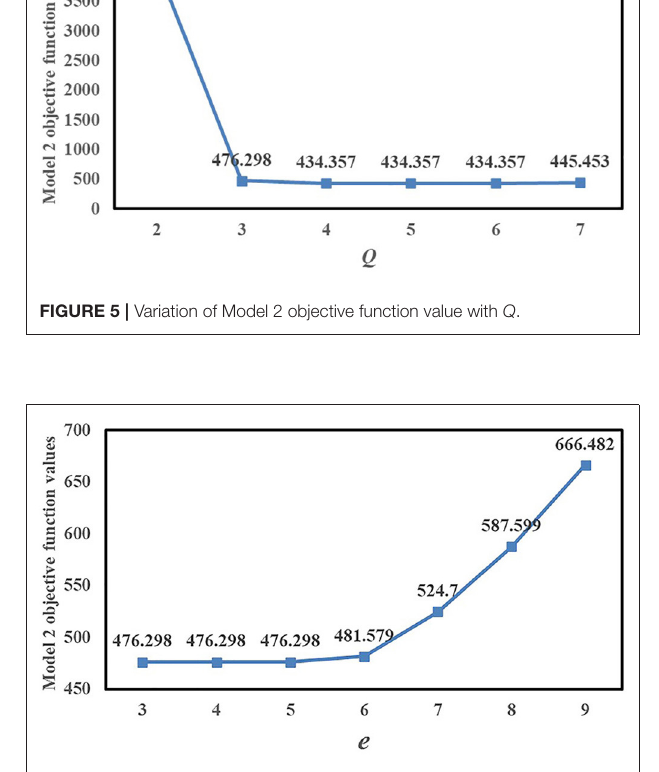
FIGURE 6 | Variation of Model 2 objective function value with e .